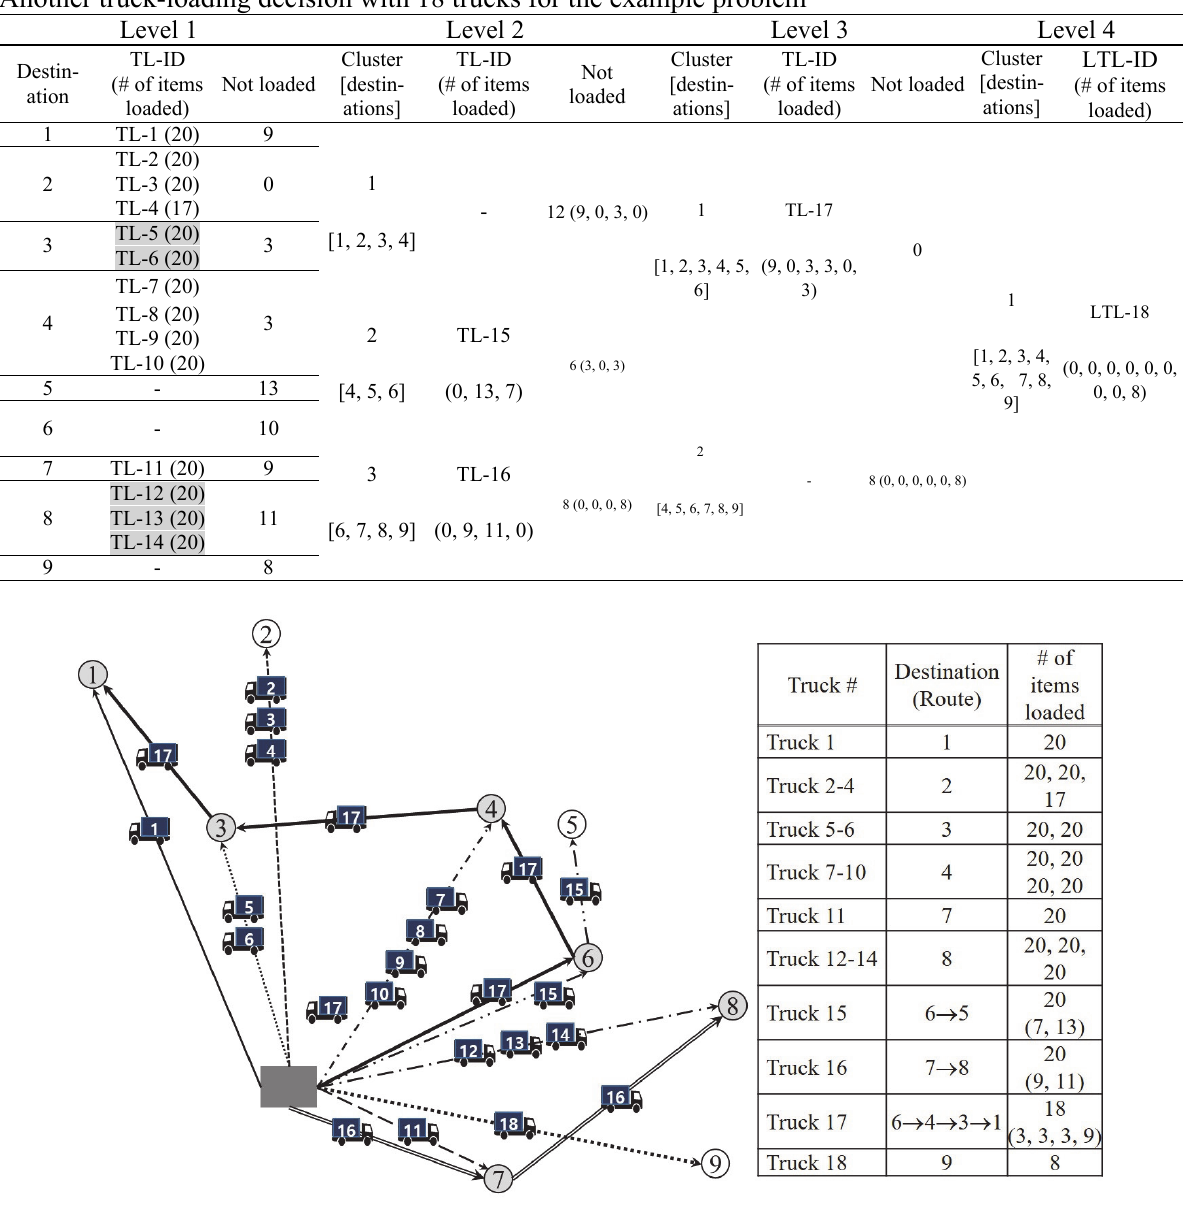
Another truck-loading decision with 18 trucks for the example problem